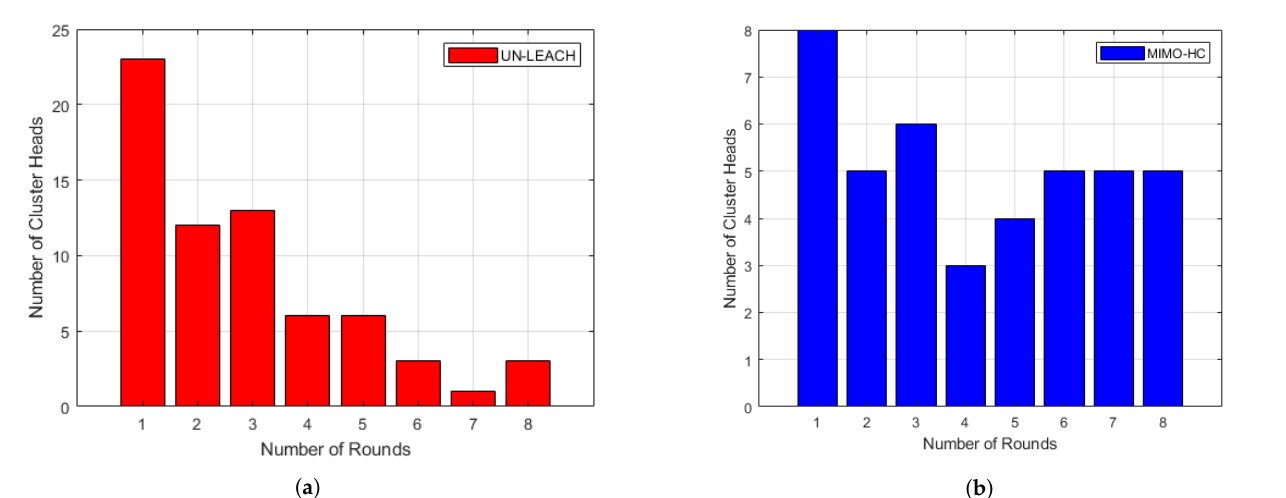
Figure 8. ( a ) Clusters distribution in UN-LEACH [11]; ( b ) Clusters distribution in